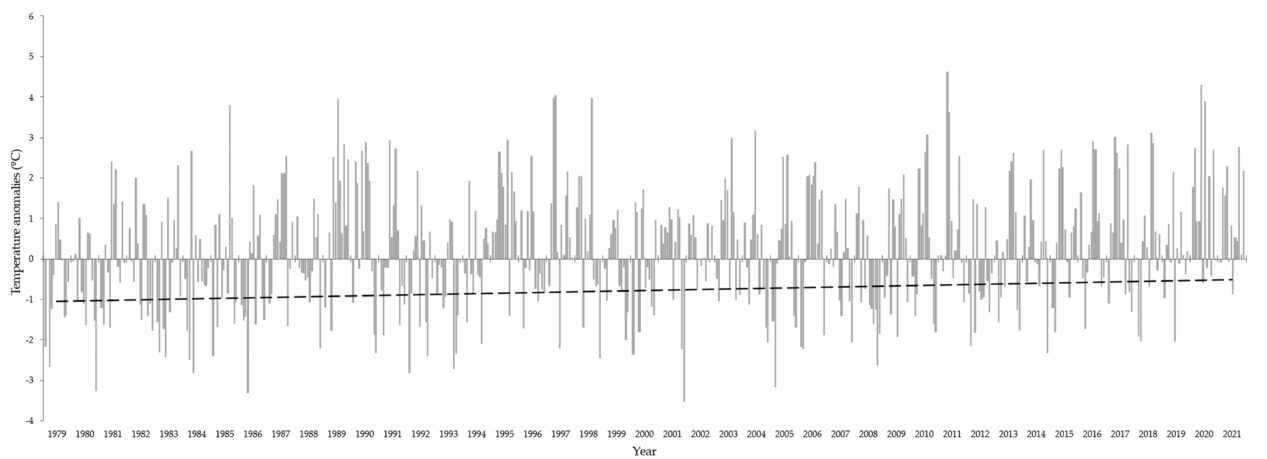
Figure 10. Distribution of monthly air temperature anomalies for each year of the period of